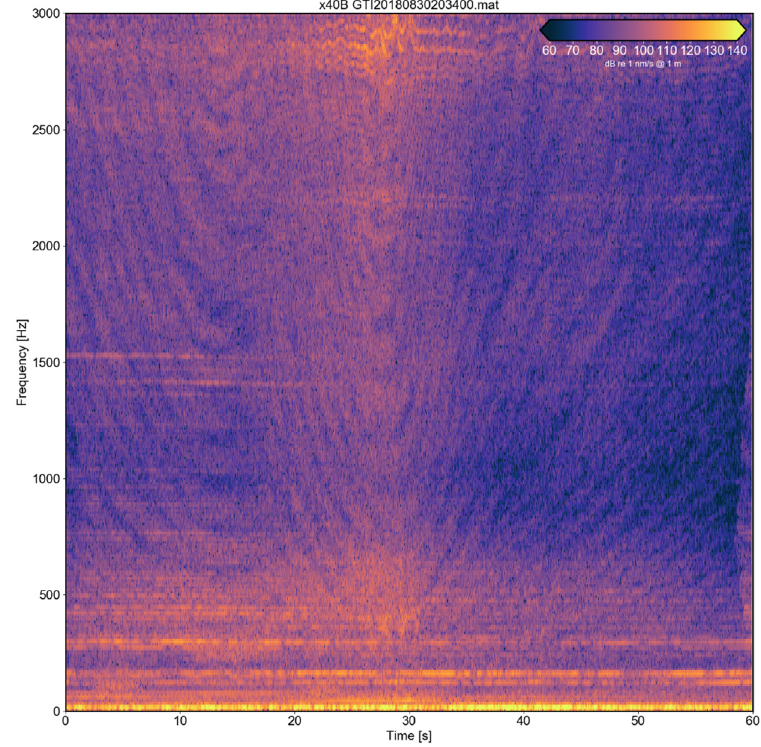
Figure 4. Particle velocity on x-channel of vector sensor M20-40, measured at the SB2 location.